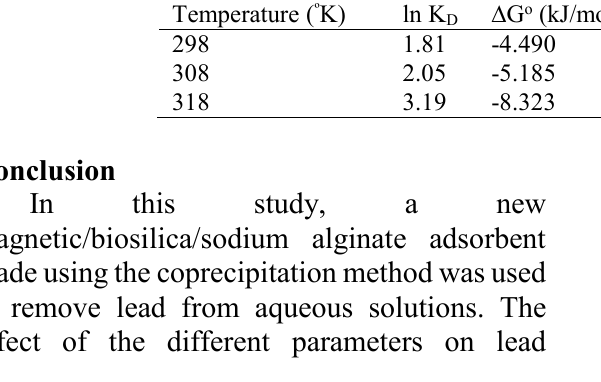
Table 3. Thermodynamic parameters for the adsorption of lead ion on MBAS Thermodynamic